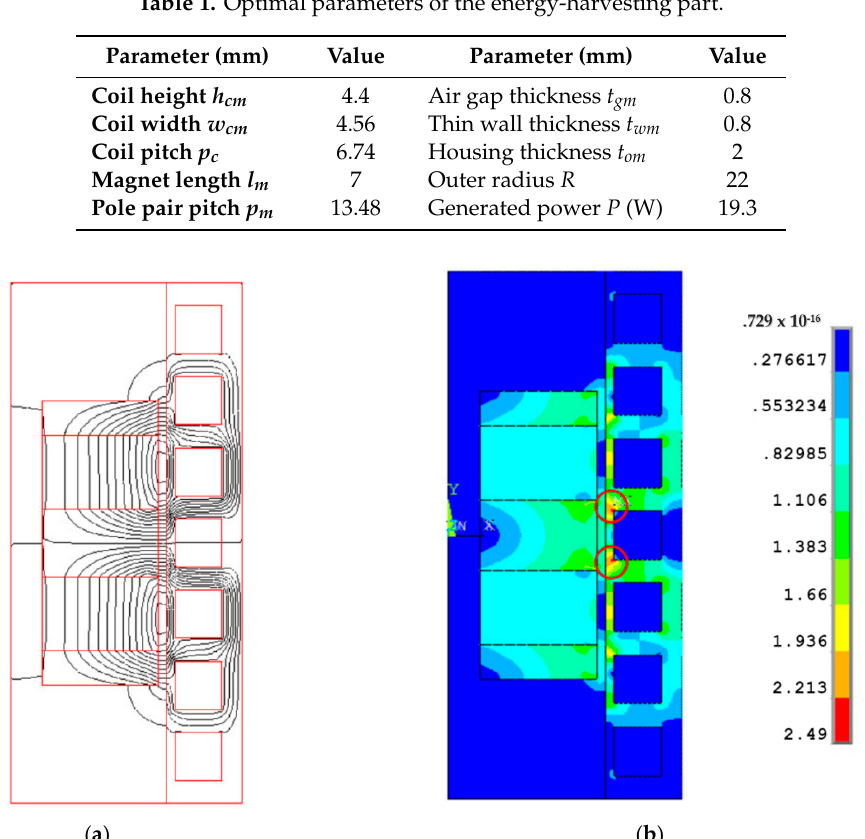
Figure 5. Finite element analysis of the optimized energy-harvesting part: ( a ) magnetic flux lines and ( b ) magnetic flux density.